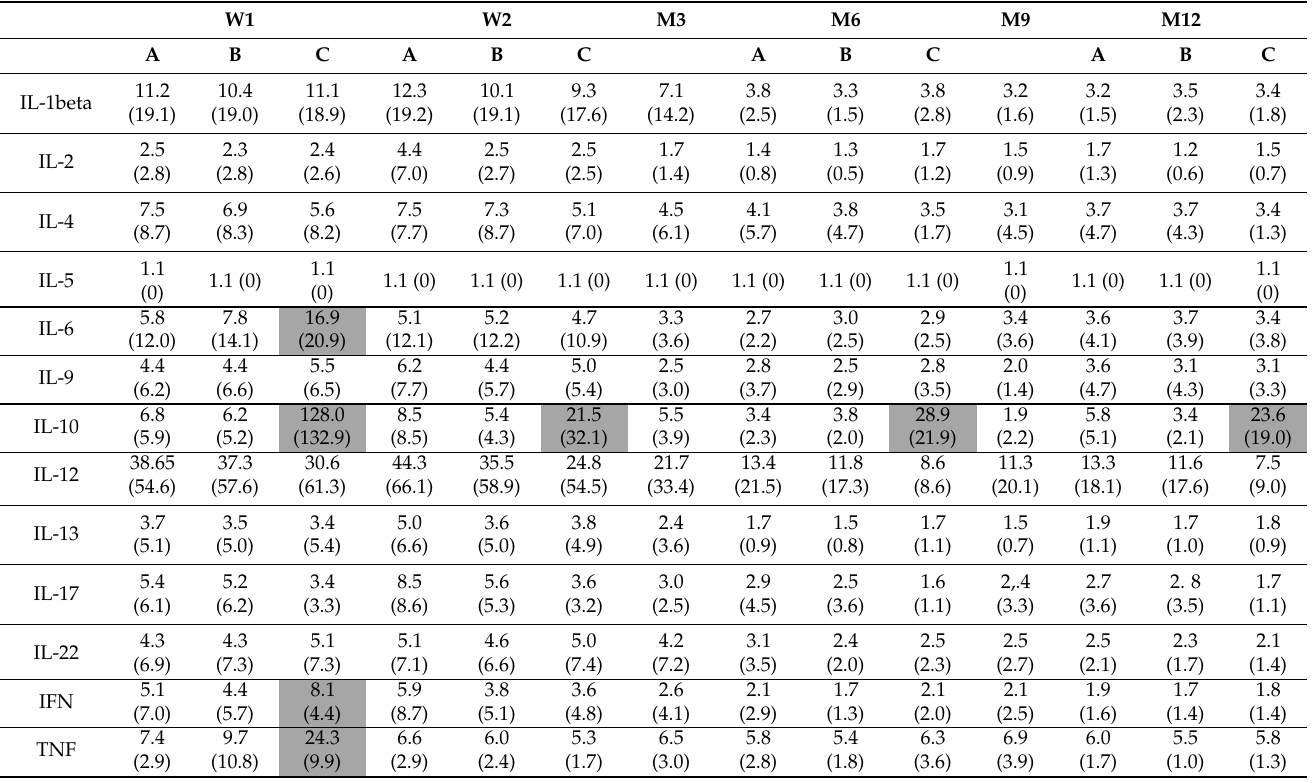
Table 2. Serum cytokine levels during OCR